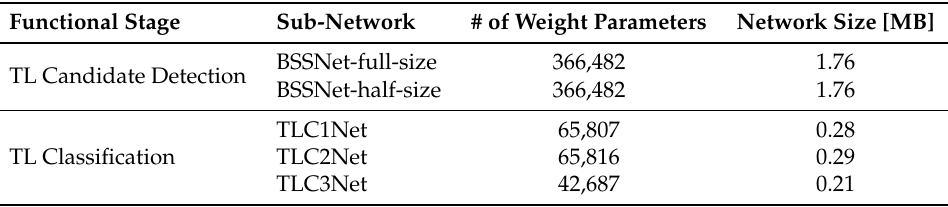
Table 7. Detail network size for each sub-network of functional stage.